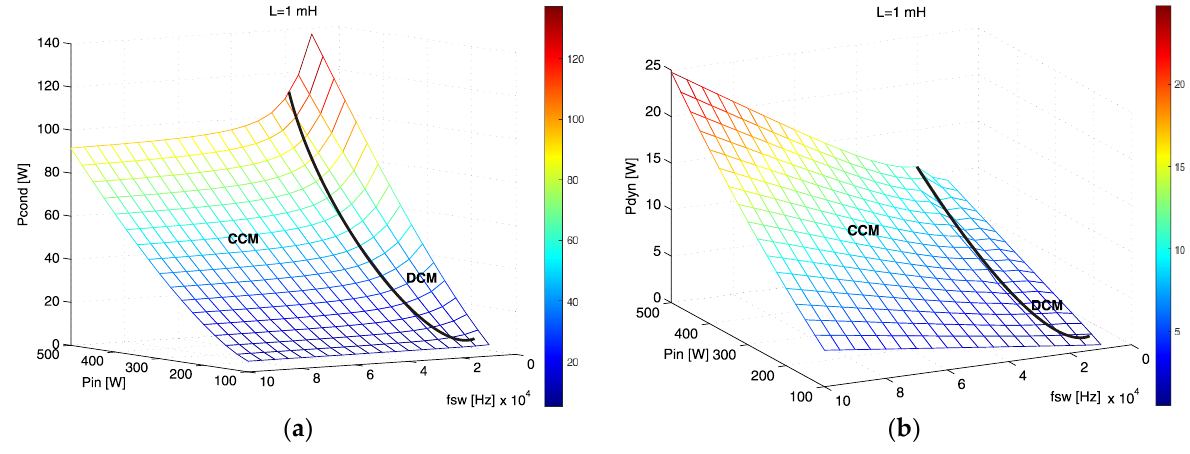
Figure 11. Push – pull converter: ( a ) Conduction power losses; ( b ) dynamic power losses. Figure 11. Push–pull converter: ( a ) Conduction power losses; ( b ) dynamic power